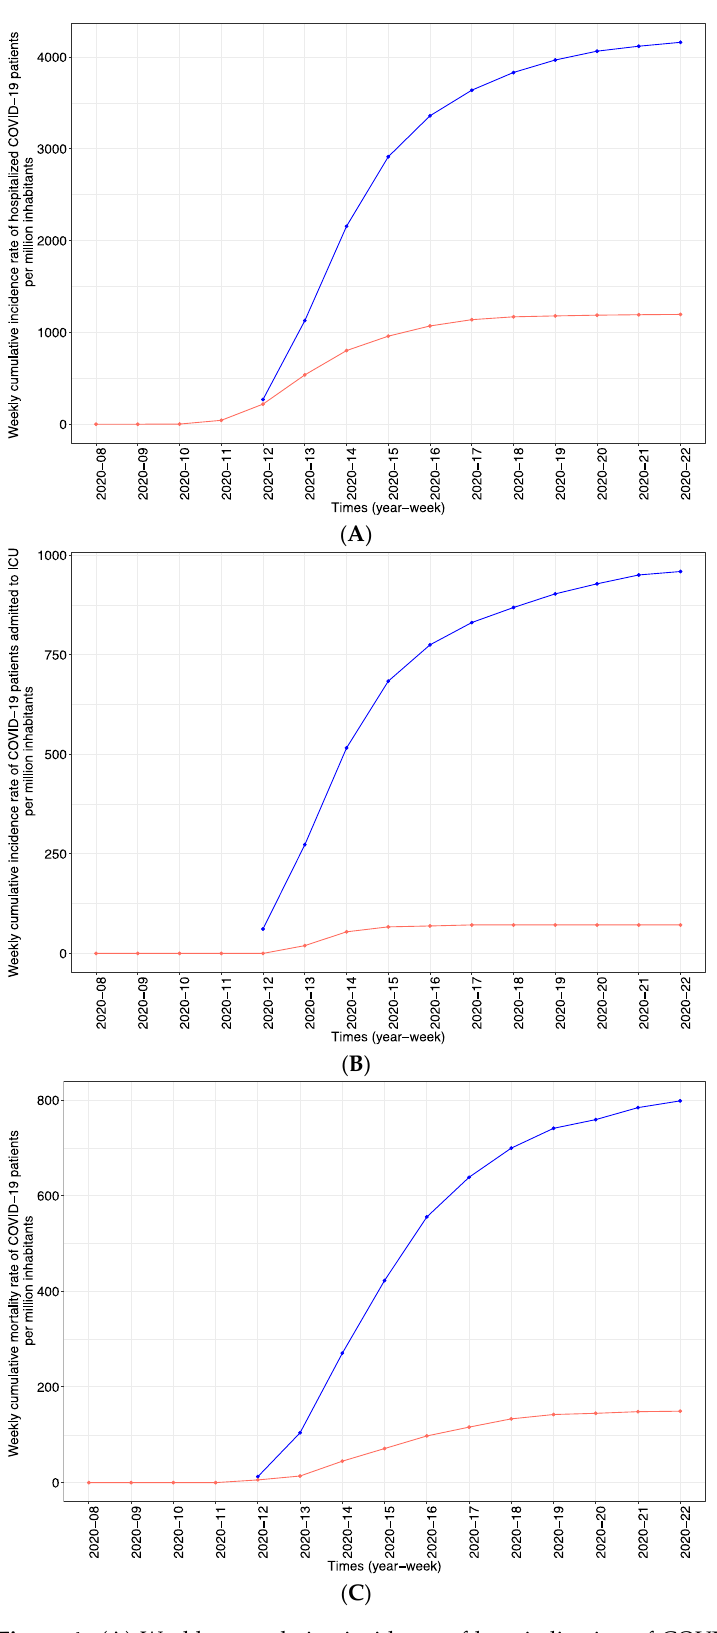
Figure 4. ( A ) Weekly cumulative incidence of hospitalization of COVID-19 patients per million inhabitants in Paris (blue) and Marseille (red). ( B ) Weekly cumulative incidence of intensive care unit (ICU) admission of COVID-19 patients per million inhabitants in Paris (blue) and Marseille (red). ( C ) Weekly cumulative COVID-19-associated mortality per million inhabitants in Paris (blue) and Marseille